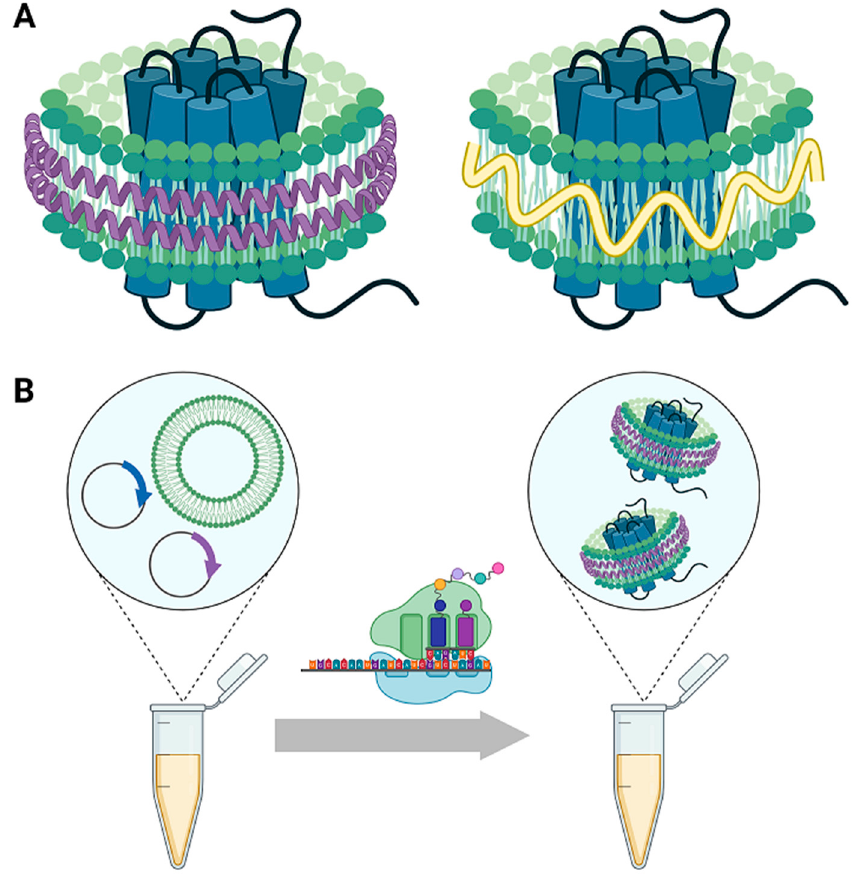
Figure 1. ( A ) Transmembrane protein embedded in a nanodisc lipid bilayer supported by ( left ) scaf- fold lipoproteins (NLPs) and ( right ) styrene maleic acid copolymers (SMALPs). ( B ) One-pot cell-free synthesis of membrane protein NLP complexes using a co-translational approach: transmembrane proteins and apolipoproteins are translated from cDNA simultaneously in the presence of liposomes using the translational machinery of an E. coli cell-free lysate, leading to the self-assembly of nanodisc loaded with the membrane protein of interest [41–43].